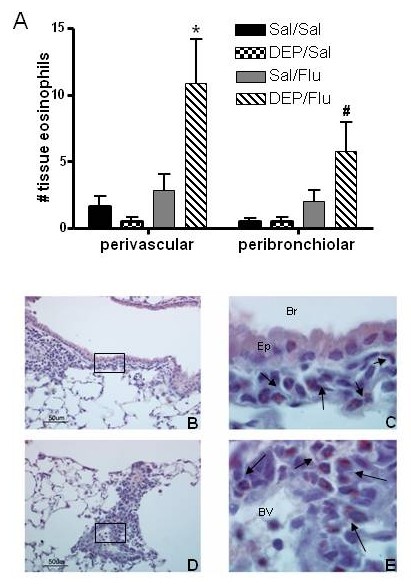
Exposure to DEP prior to infection with influenza increases tissue eosinophils levels in OVA-sensitized mice. Lung sections stained for eosinophils using Carbol Chromotrope were analyzed for the presence of perivascular and peribronchial eosinophils. A.) Average numbers of tissue eosinophils located around small airways (150–200 μm) and blood vessels (10–50 μm). B-E.) Representative images from an animal exposed to DEP prior to infection with influenza illustrating the number of infiltrated eosinophils around the airways and blood vessel. Images illustrating peribronchial accumulation of eosinophils (B + C) at 40× (B) and 100× (C) magnification and perivascular accumulation of eosinophils (D + E) at 40× (D) and 100× (E) magnification. Br = bronchi; Ep = epithelium; BV = blood vessel, arrows point to individual eosinophils. *significantly different from Sal/Sal control; p < 0.05.